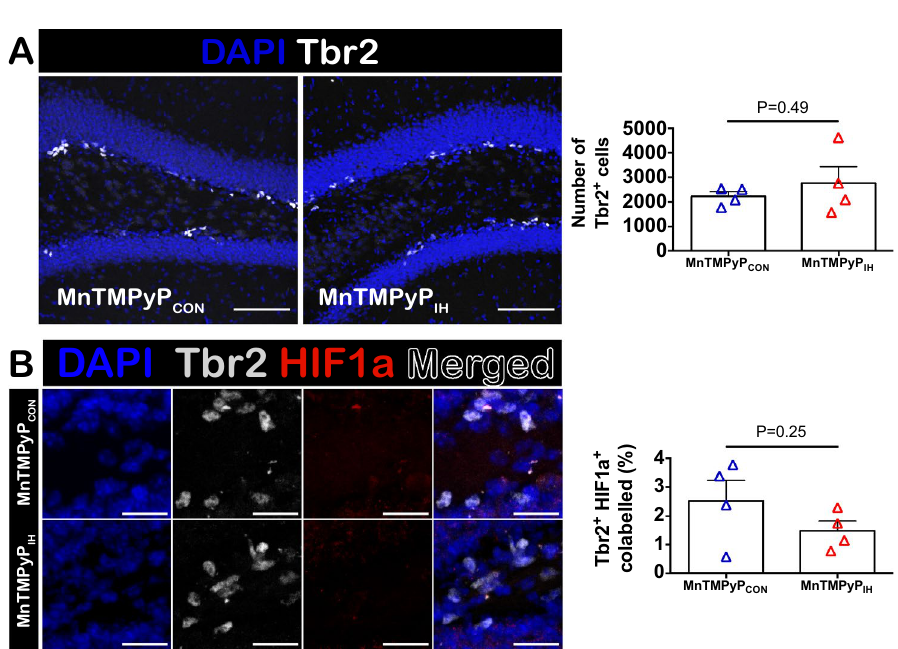
Figure 6. Antioxidant treatment during IH 10 prevents a reduction in Tbr2 + cells and prevents an increase in HIF1a expression. ( A ) Representative images of SGZ in MnTMPyP-treated control (MnTMPyP CON ) and MnTMPyP-treated IH 10 animals (MnTMPyP IH ). Scale bars are 100 μm. There was no difference in the number of Tbr2 + INPs (CON: n = 4, IH 10 : n = 4). ( B ) Representative images of co-labeled HIF1a + Tbr2 + cells. Scale bars are 20 μm. The proportion of HIF1a + Tbr2 + was also not different following IH 10 with MnTMPyP (MnTMPyP CON : n = 4, MnTMPyP IH : n = 4). Scale bars are 20